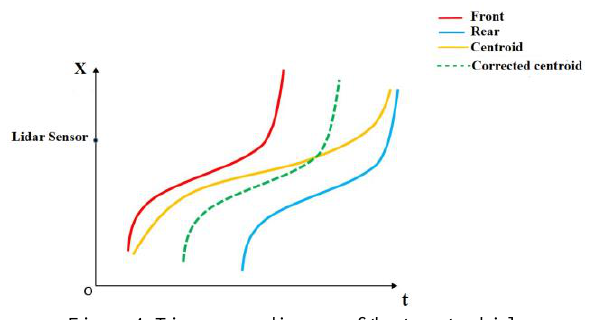
Figure 4. Time-space diagram of the target vehicle.